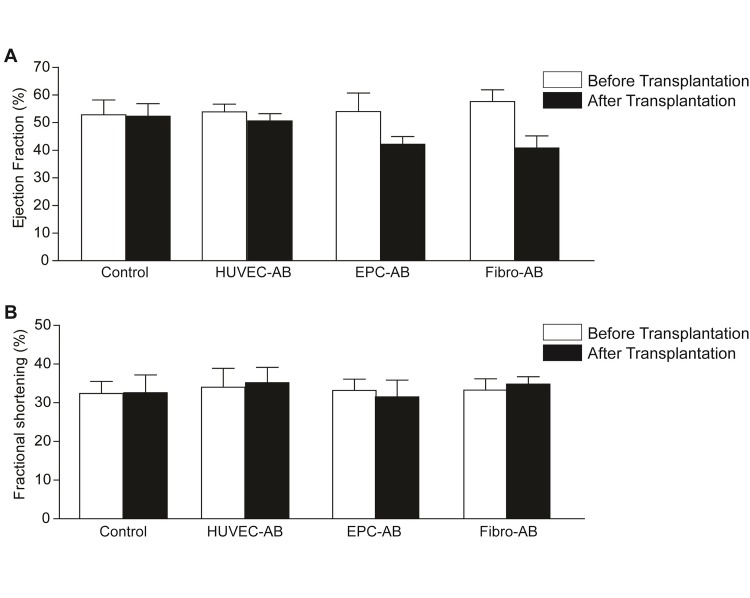
The effect of apoptotic bodies transplantation on heart parameters after myocardial infarctionAnalysis of the functional parameters of the heart by echocardiography demonstrated no significant improvement of ejection fraction (A) and fractional shortening (B) after apoptotic bodies transplantation in all four groups, before (empty bars) and after transplantation (full bars).